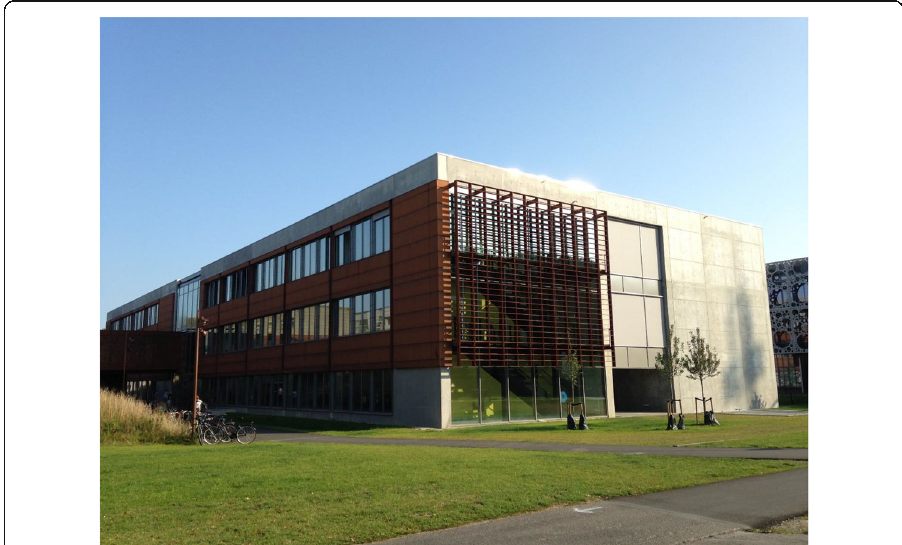
Fig. 4 Building OU44 at the University of Southern Denmark Odense